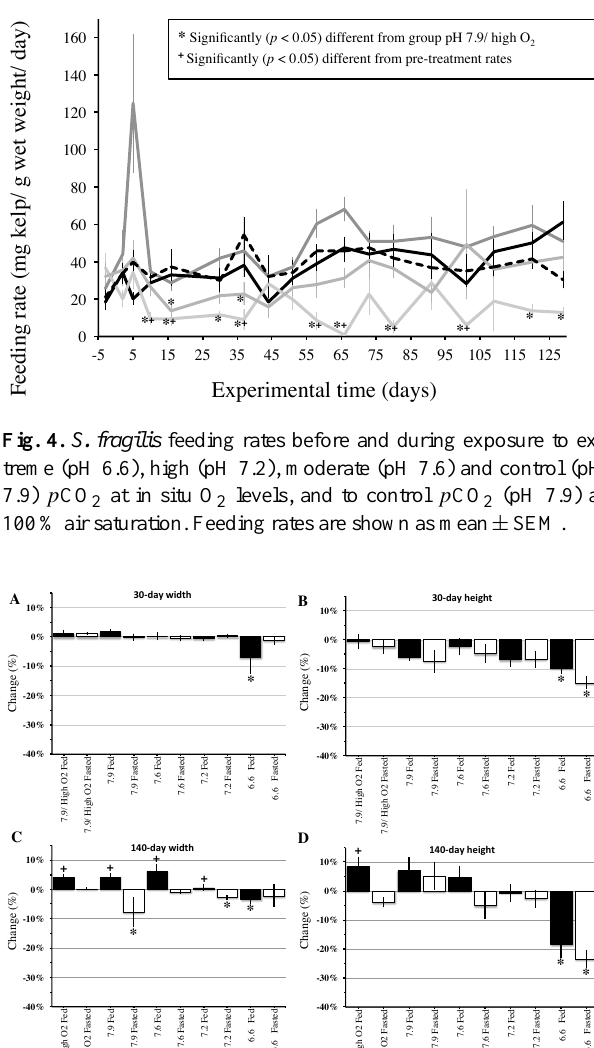
pH 7.9/high O 2 (Mann-Whitney U test, U = 2, p = 0 . 007). Conversely, urchins at pH 6.6 (Fig. 5c, Mann-Whitney U test, U = 21, p = 0 . 570) did not show correlation of width and feeding after 140 days of treatment exposure. Changes in height (Fig. 5d) were significantly correlated (positively) with feeding only in urchins exposed to pH 7.9 at high O 2 levels (Fig. 5d, Mann-Whitney U test, U = 4, p = 0 . 015). After 140 days, fed (Fig. 5d, Mann-Whitney U test, U = 35, p = 0 . 005) and fasted (Fig. 5d, Mann-Whitney U